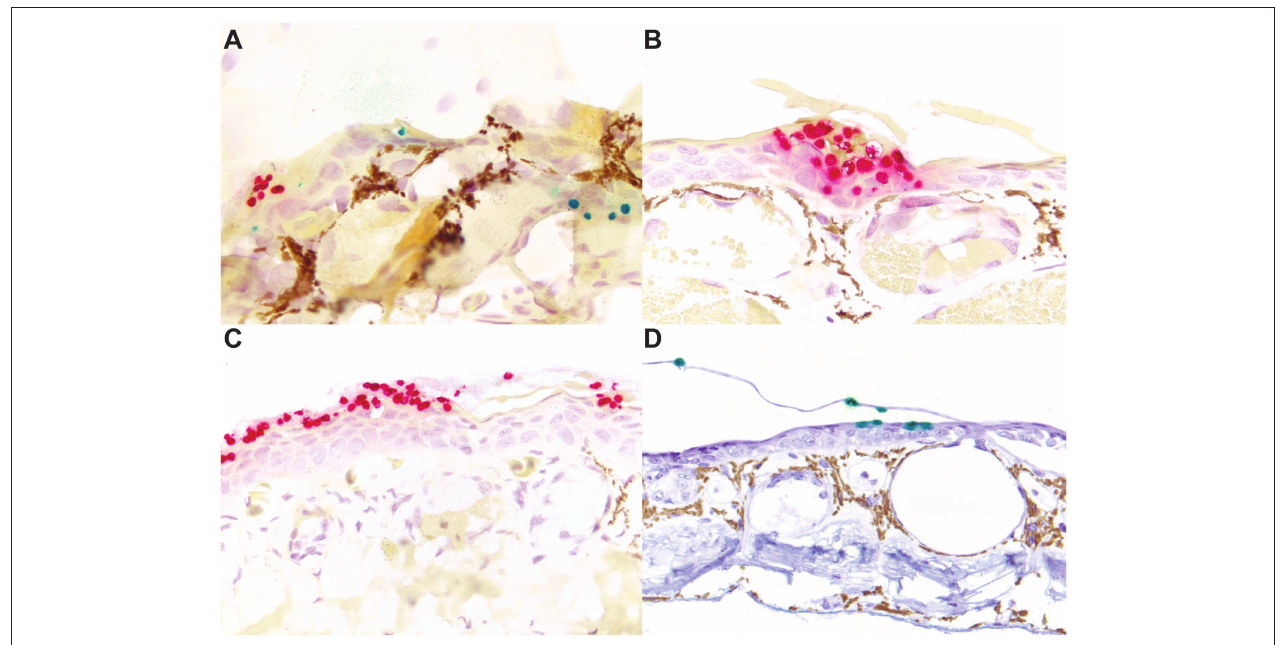
FIGURE 3 | Bd / BSal RNAScope ® ISH of skin sections of mixed species with chytridiomycosis. Concurrent Bd and Bsal chytridiomycosis in an experimentally infected red-legged false brook salamander ( Aquiloeurycea cephalica ; A ). Bsal chytridiomycosis in an experimentally infected large-blotched ensatina ( Ensatina eschscholtzii klauberi ; B ) and a red salamander ( Pseudotriton ruber ; C ). Bd chytridiomycosis in a naturally infected little devil poison frog ( Oophaga sylvatica; D ). Bd probe binding is visualized by green staining (A,D) and Bsal probe binding is visualized by red staining (A–C) . The golden tinctorial property of ( A–C ) is an artifact of the counterstain occasionally seen. (A,B) are at 400x magnification; (C,D) are at 200x